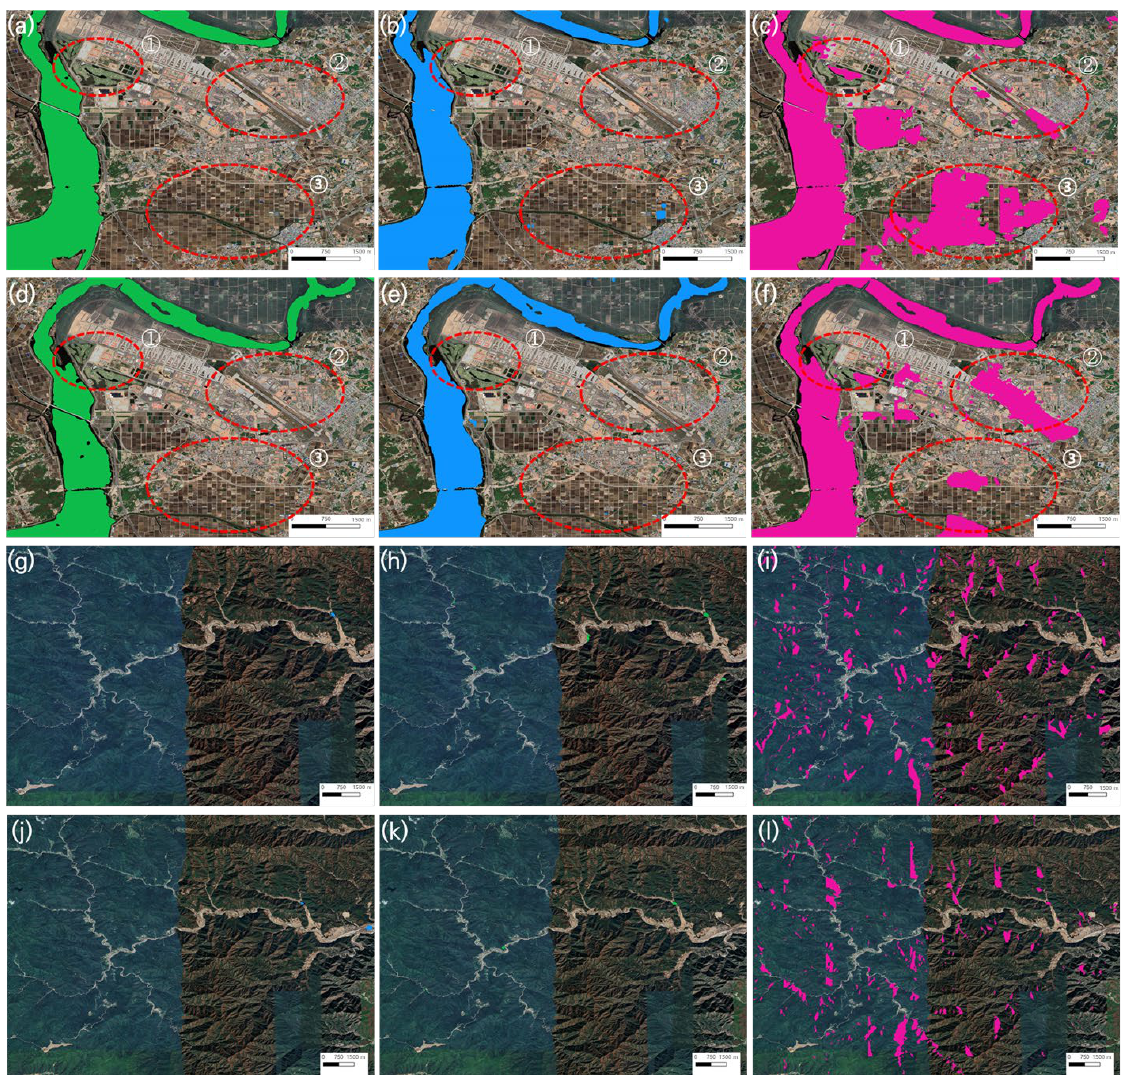
Figure 10. Segmentation results overlaid on Google Earth images (( a – c , g – i ) are for 2020, ( d – f , j – l ) are for 2022; first column—VV, AS, TWI, BF combination, second column—VV, DEM, SL, BF, combination, and third column—VV images; first and second rows 1 (cid:13) to 3 (cid:13) show differences in segmentation results for airport runways, golf courses, and paddy fields, respectively, and the third and fourth rows show differences in segmentation results for mountain shadows.